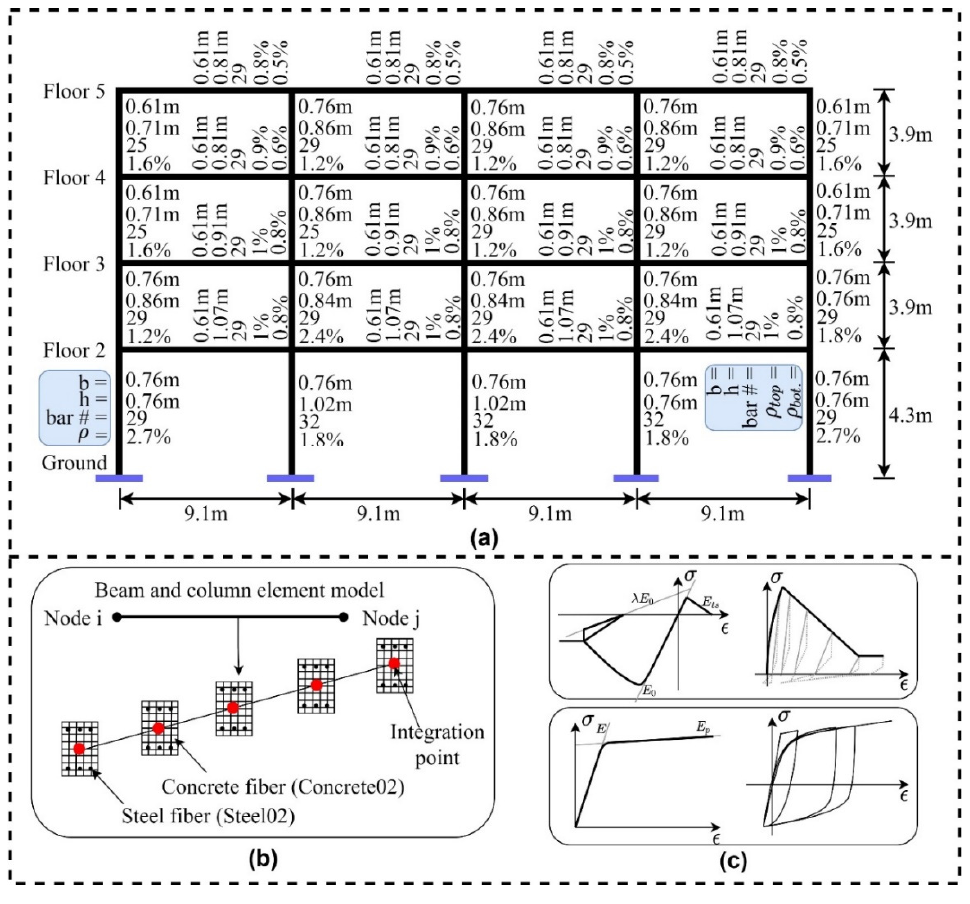
Figure 4. ( a ) The fixed-base benchmark r/c frame with beam and column design information; ( b ) the fiber-distributed plasticity element of beams and columns with Concrete02 material model and Steel02 material model in OpenSEES; ( c ) the stress and strain relationship ( left ); and the hysteretic behavior ( right ) of Concrete02 ( top ) and Steel02 ( bottom ).